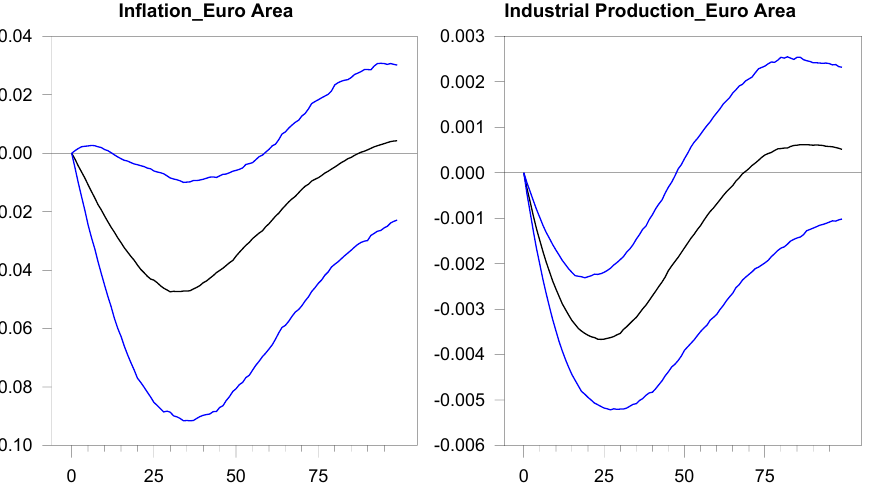
Figure 6. Responses of Euro Area inflation and industrial production to a contractionary monetary policy shock. Monetary policy shock identified as exogenous innovation to the differential between the European Overnight Average Interest Rate (EONIA) and the Federal Funds Rate. Error bands set at the 10th and the 90th percentiles.